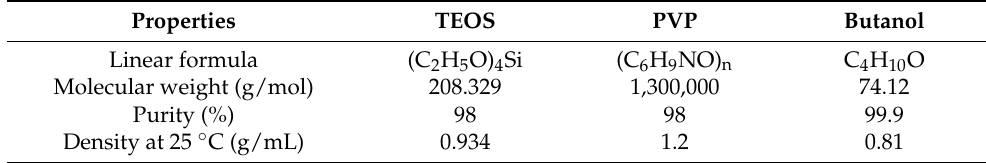
Table 2. Properties of TEOS, PVP, and butanol.